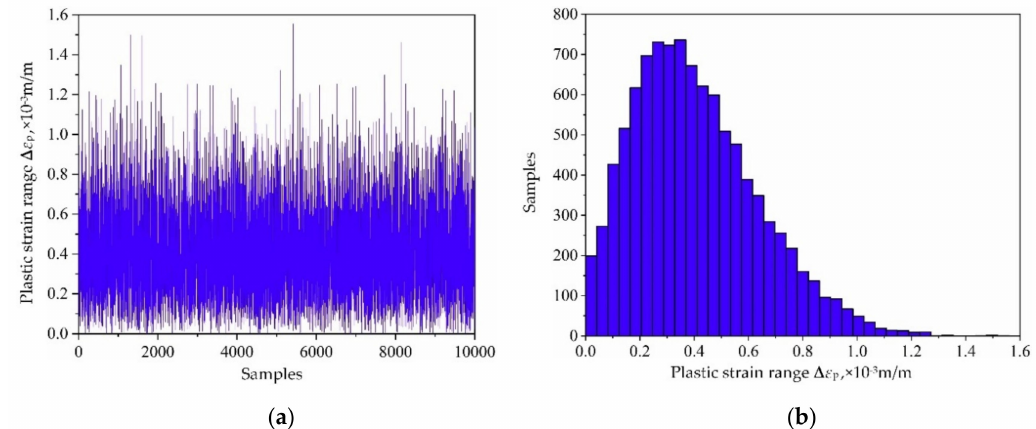
Figure 12. Output responses of decomposed IKM-3: ( a ) simulation history, ( b ) probabilistic